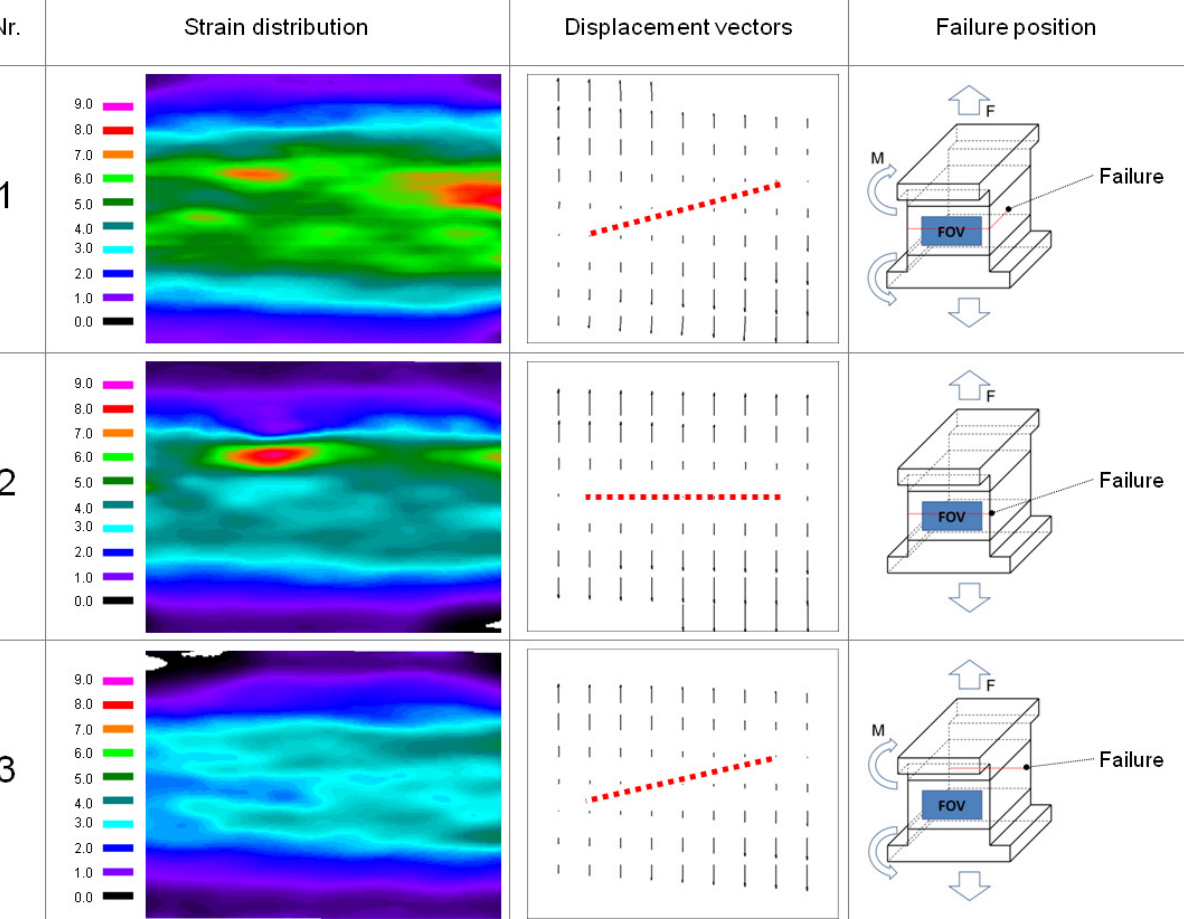
ε )/( mmm µ ; ( middle ) displacement vectors yy